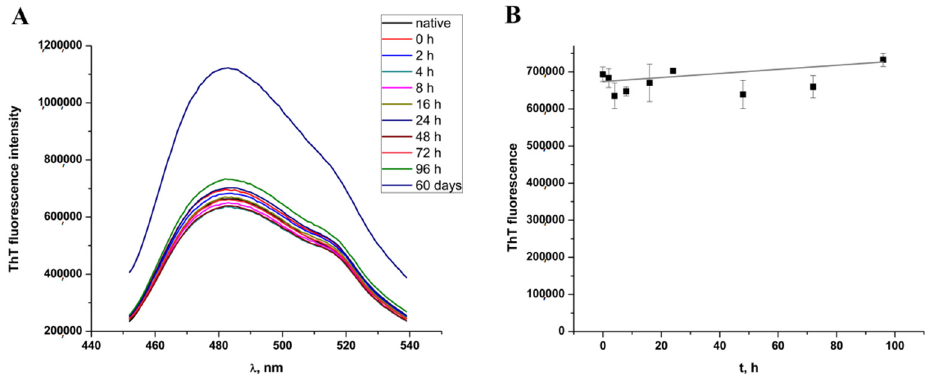
Figure 1. ( A ) Thioflavin T (ThT) fluorescence spectra during four day’s HEWL incubation in 90% ethanol and after a 60-day incubation period. ( B ) Time-dependent change of ThT fluorescence over four days’ incubation of HEWL in 90% ethanol solution.